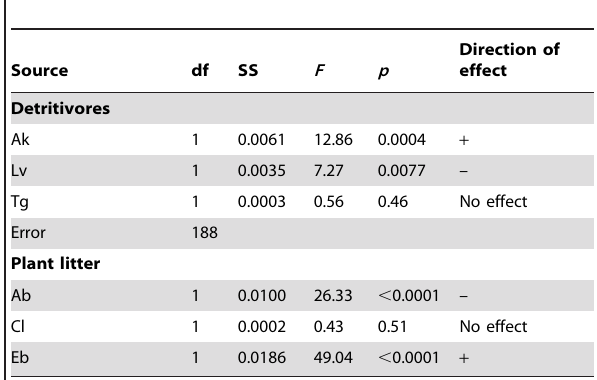
Table 2. Results of general linear models testing effects of detritivore and plant litter species identity on decomposition rates (measured as the proportion of leaf weight loss per